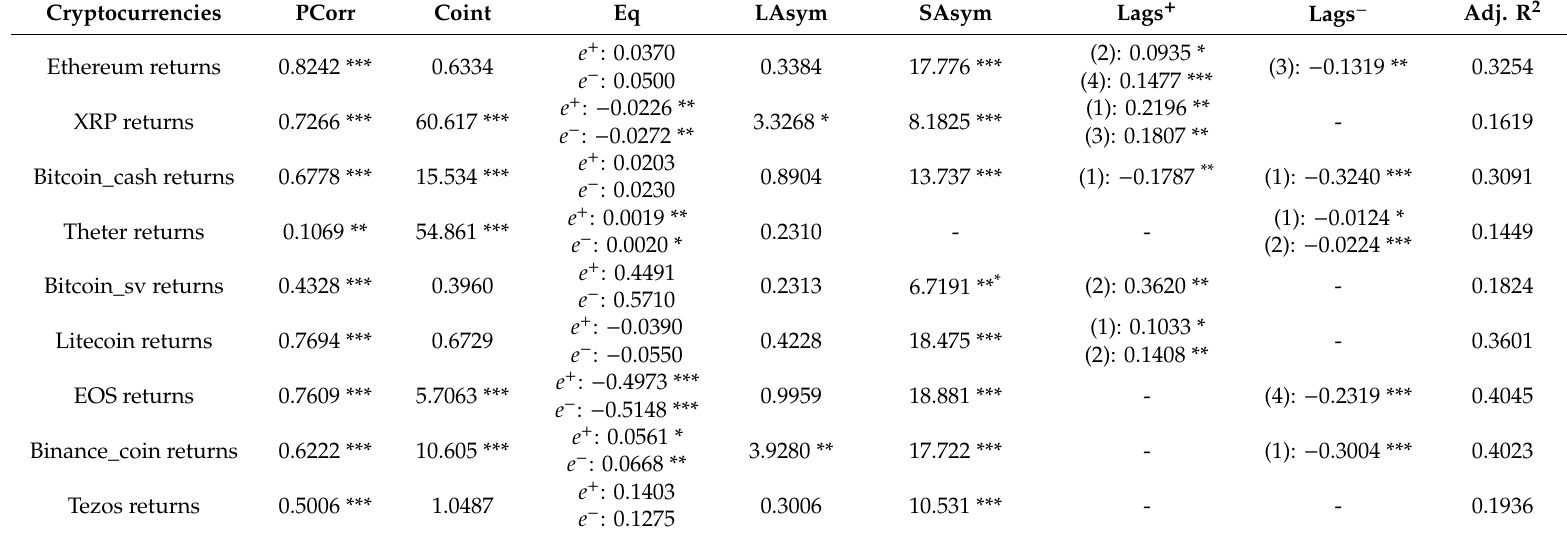
Table 3. Regression results of nonlinear ARDL models: asymmetry and cointegration tests between Bitcoin returns and the rest of relevant cryptocurrencies’ returns: daily frequency.